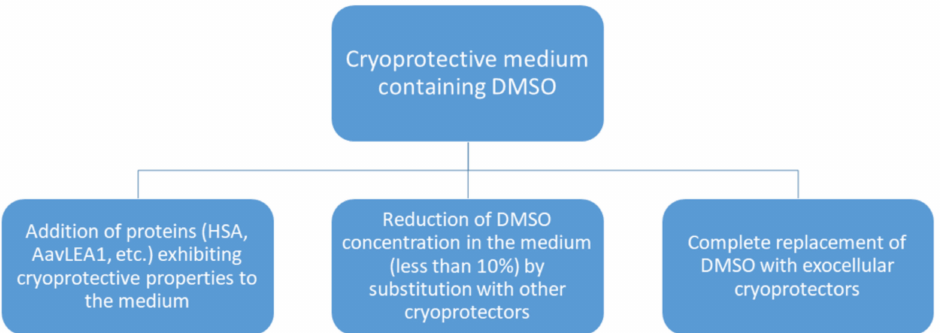
Figure 3. Ways to reduce the cytotoxicity of cryoprotective media containing